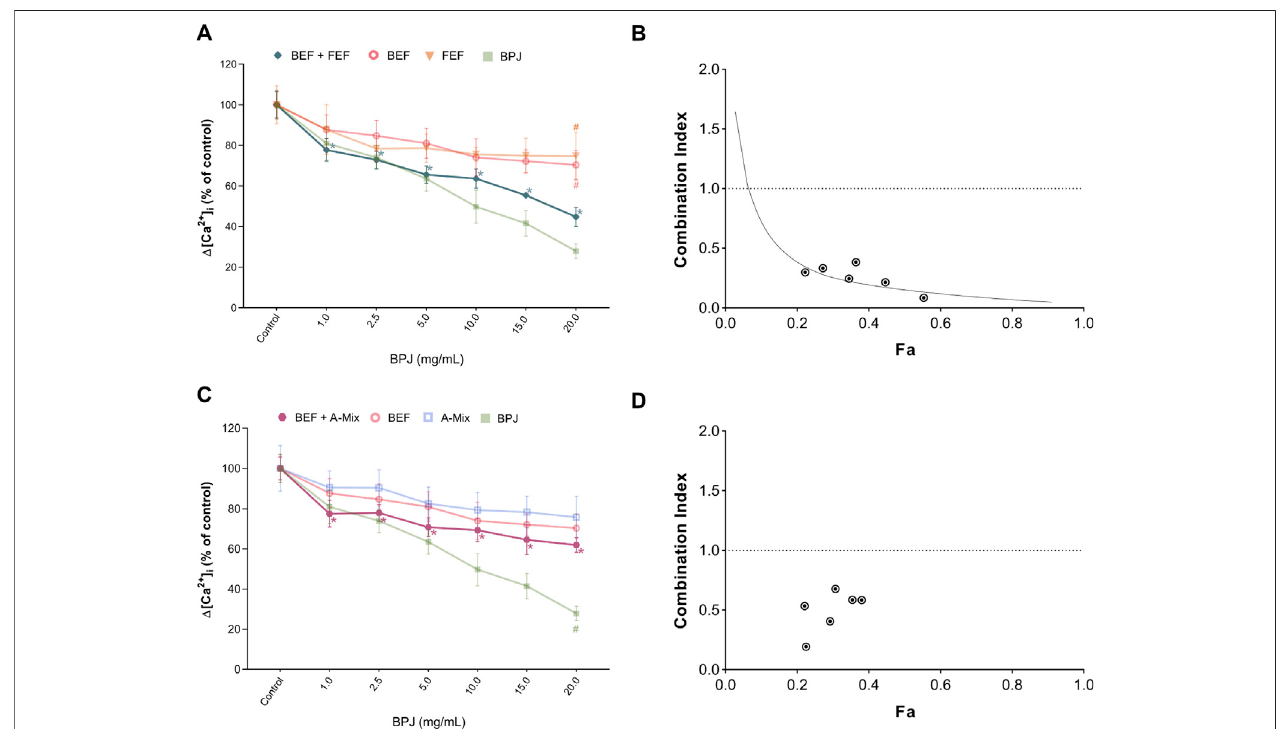
FIGURE2| EffectofthecombinationofBPJfractions/compoundsontheOT-inducedriseof[Ca 2+ ] i .Cellswerepre-treatedwithBEFplusFEF (A) ,orwithBEFplus A-Mix (C) prior to stimulation with 100 nM OT. Results of pre-treatment with BPJ and each substance alone are shown in transparent lines (signi fi cance symbols regarding comparison to control omitted). Values represent the mean ± SEM of six independent experiments performed in quadruplicate and are expressed as percentageofcontrol;* p < 0.05compared withcontrol; # p < 0.05compared tocombination.Combinationindex(CI)valuesofthecombinationofBEFwithFEF (B) or with A-Mix (C) were calculated from the concentration-response curves. Data were analyzed by the median-effect method. Fa: fraction affected.